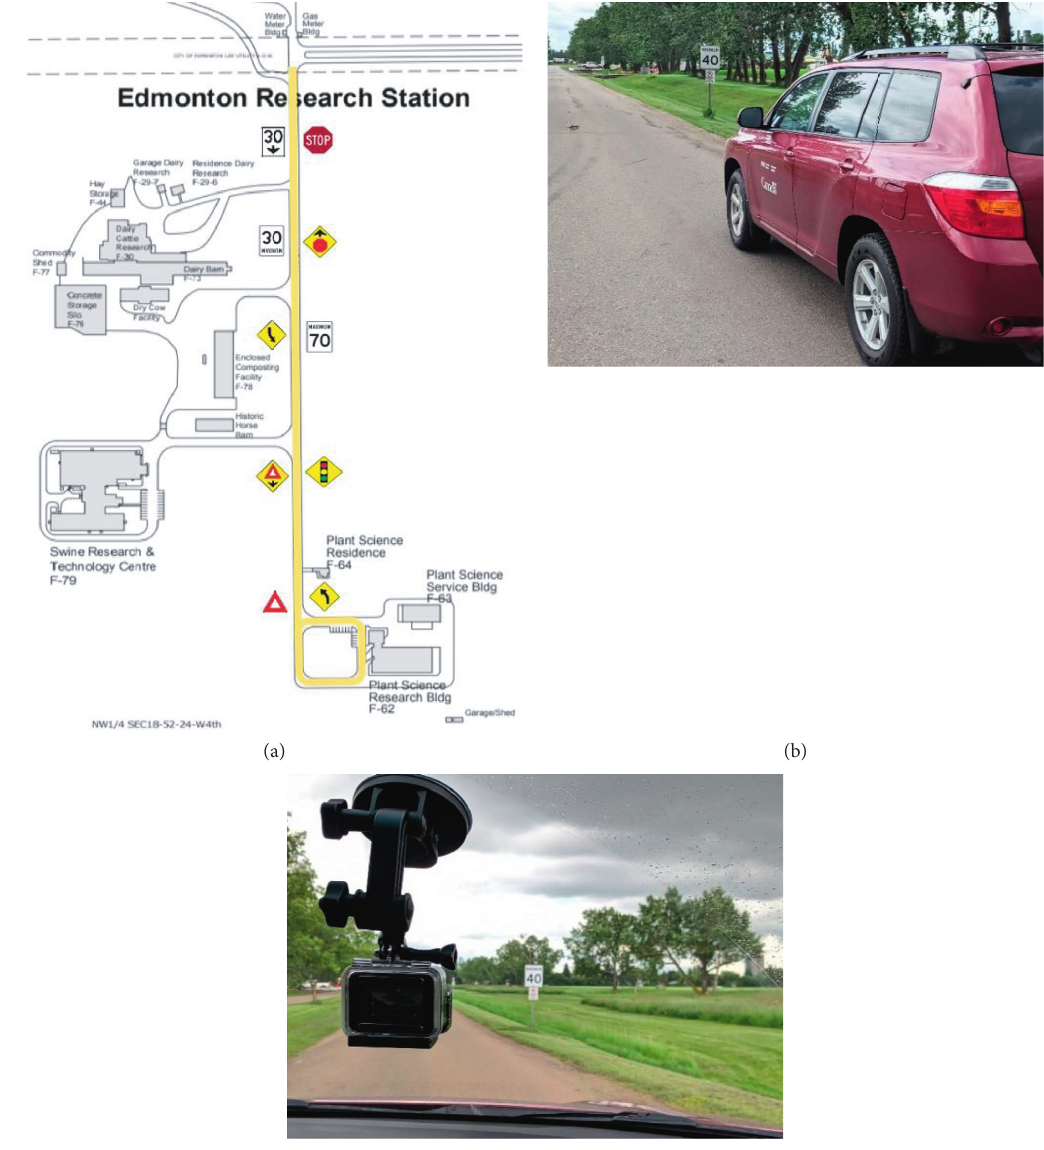
Figure 1: (a) Plan of data collection test track. (b) Vehicle. (c) Camera used for recording videos of traffic